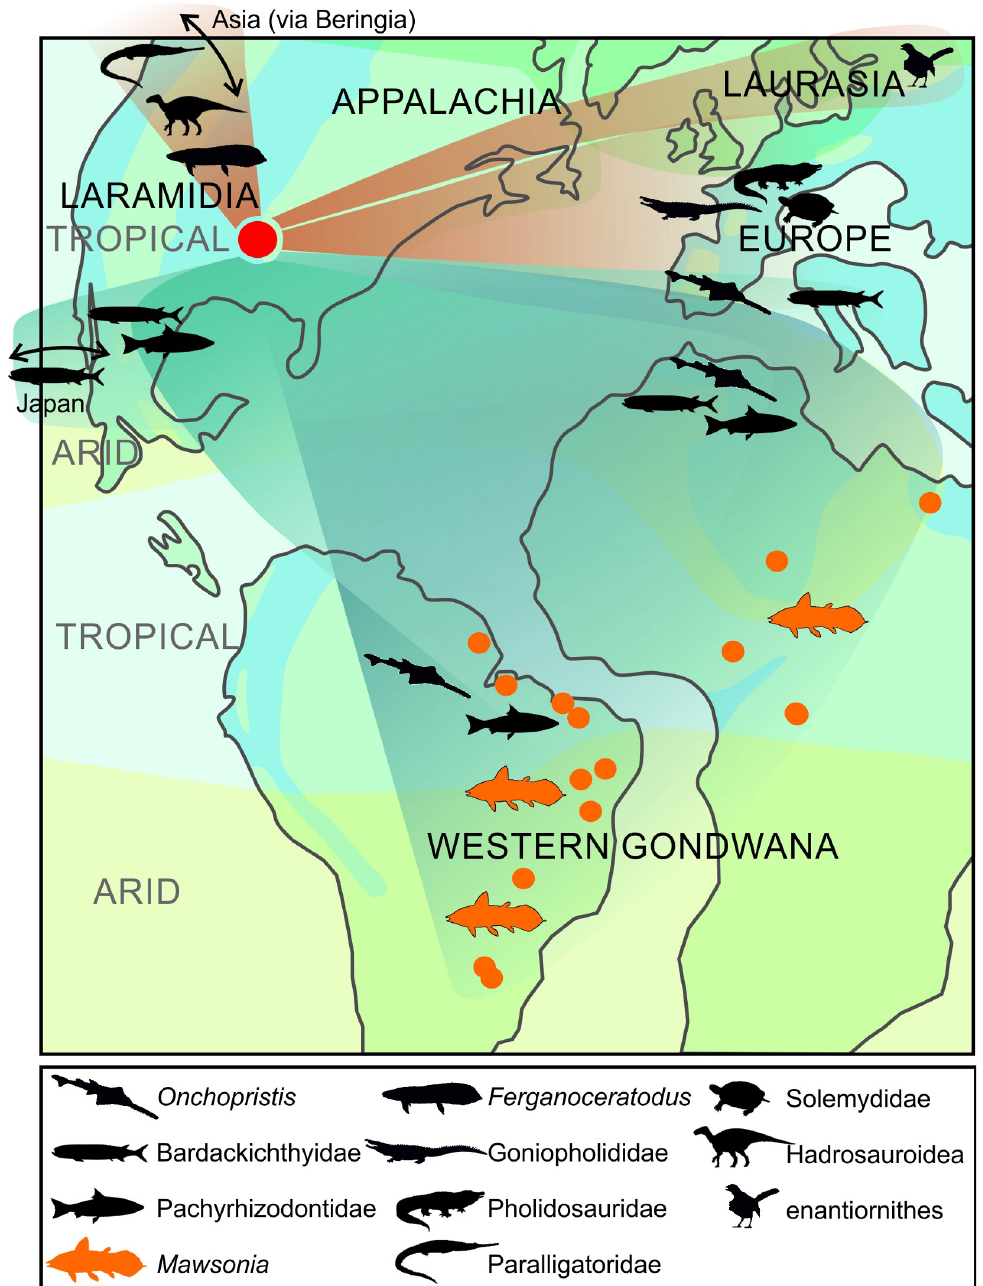
Fig 8. ‘Mid’-Cretaceous paleogeographical map of western Laurasia and western Gondwana showing biogeographical affinities of vertebrates from the woodbine formation (red circle). Brown areas indicates continental vertebrates and the blue areas indicate brackish and marine vertebrates. Orange dots indicate approximate locations of records of Mawsonia